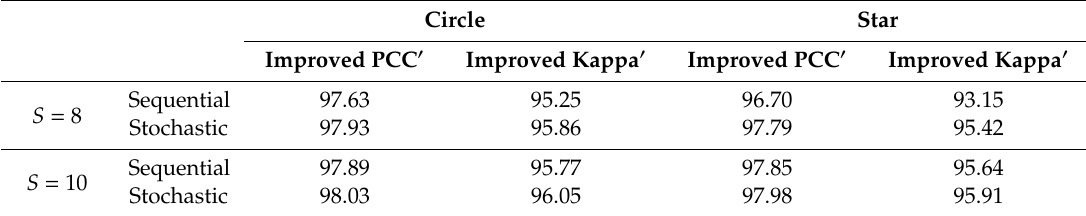
Table 11. Accuracies (%) of two optimization methods for the PSA_MSA1 algorithm. Circle